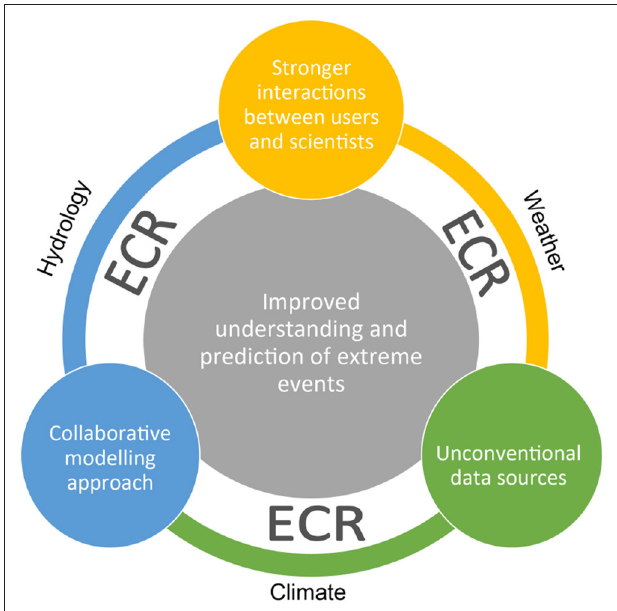
FIGURE 2 | Ways forward toward regional information for improved understanding and prediction of CWH extreme